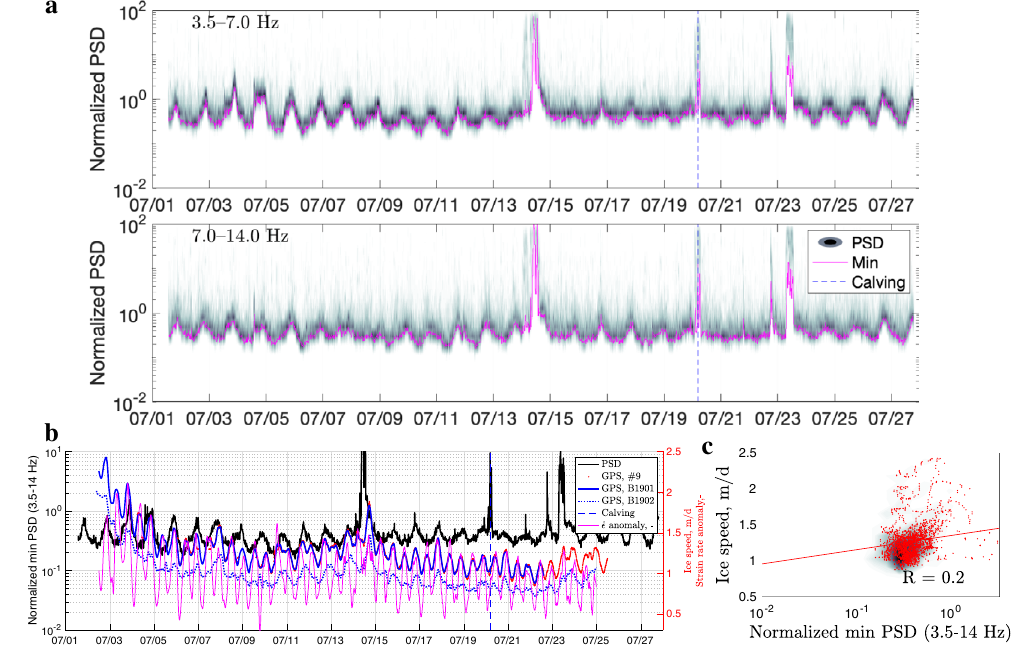
Fig. 6 Analysis of data from the 2019 on-rock station (BWG24). a Density plot of the normalized noise amplitude variations for 3.5 – 14.0 Hz frequency bands (for velocity power spectral density, PSD). Each magenta curve marks the lowest noise level in a given frequency band. The colour scale is the same as in Fig. 2c (0 – 35). The dashed blue line indicates the timing of a major calving event on 20 July. b Minimum seismic tremor amplitude (3.5 – 14.0 Hz) versus glacier displacement rate at Global-Positioning-System (GPS) stations B1901, B1902, and #9, with the corresponding strain rate anomaly, _ ϵ (i.e., deviation from the mean). The dashed blue line indicates the timing of a major calving event. c Scatter and density plots showing the correlation between the seismic signal and horizontal GPS displacement rate at B1901 for overlapping data ( R is the Pearson correlation coef fi cient). The red line is the regression fi t.